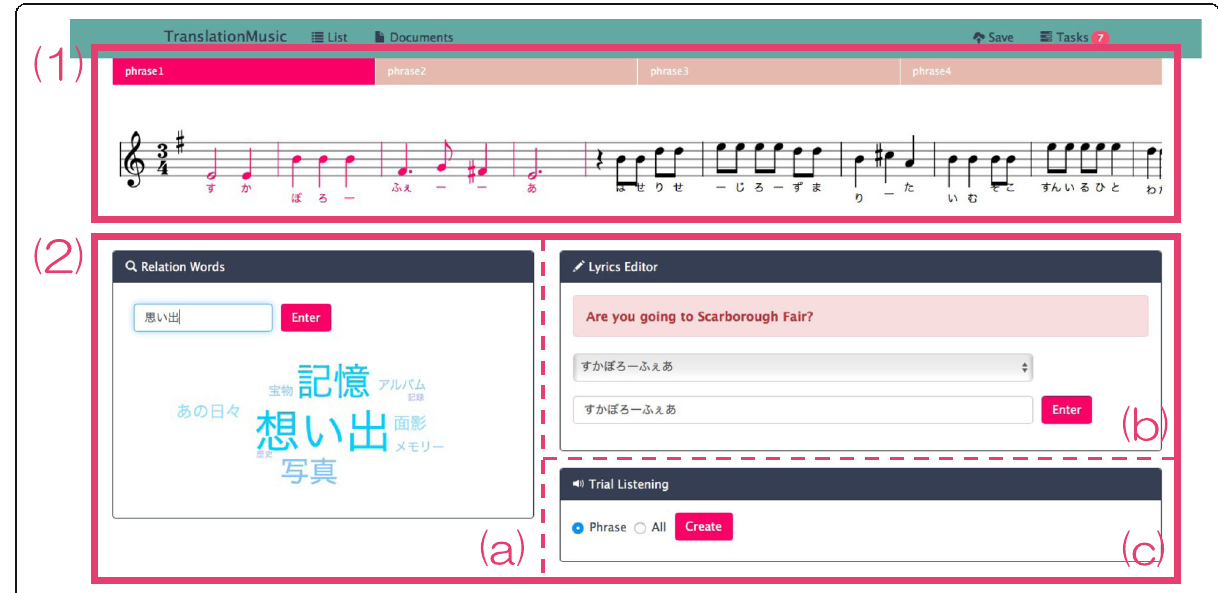
Fig. 5 Lyrics transcreation application (arranged from ref.